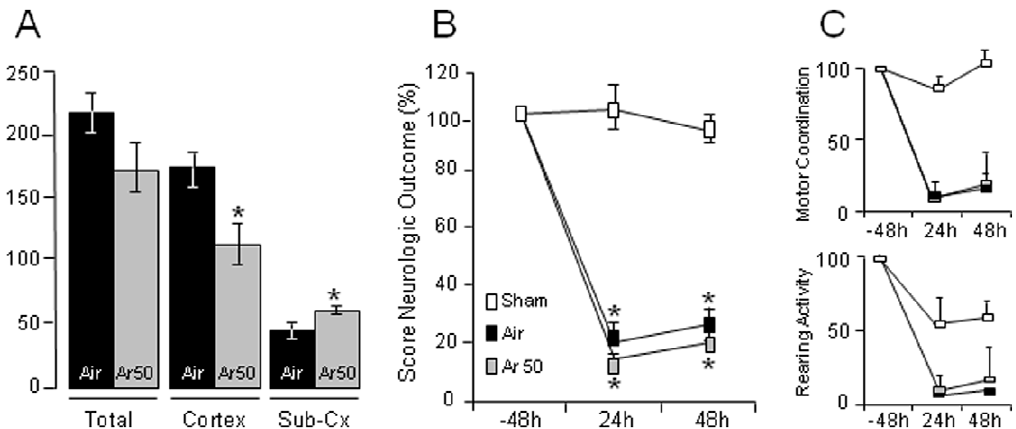
Figure 3. Effects of argon (Ar) at 50 vol% on MCAO-induced brain damage and behavioral motor deficits (n=14 per group). ( A ) Control rats subjected to MCAO (treated with medical air) exhibited significant cortical and subcortical brain damage. Sham rats had no brain damage (data not shown). Argon at 50 vol% produces cortical neuroprotection, but did increase subcortical brain damage. ( B ) MCAO-induced global score of neurologic outcome. Control rats (line with black boxes), but not sham rats (line with white boxes), exhibited neurological deficits. Rats treated with argon at 50 vol% (line with gray boxes) showed no improvement of neurologic deficits as compared to control rats treated with medical air. ( C ) Scores of motor coordination and rearing activity in sham rats, control animals treated with medical air, and rats treated with argon at 50 vol%. Data